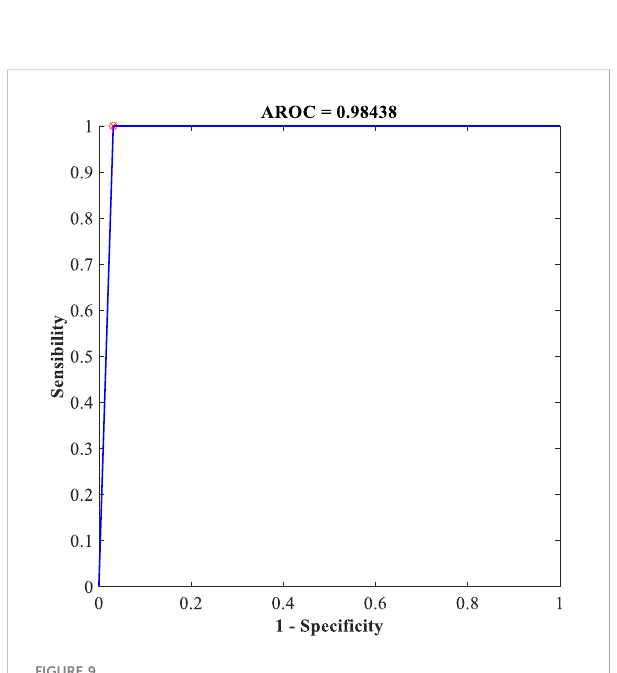
FIGURE 9 ROC for the best achieved results by the FLN algorithm using the WDBC database.